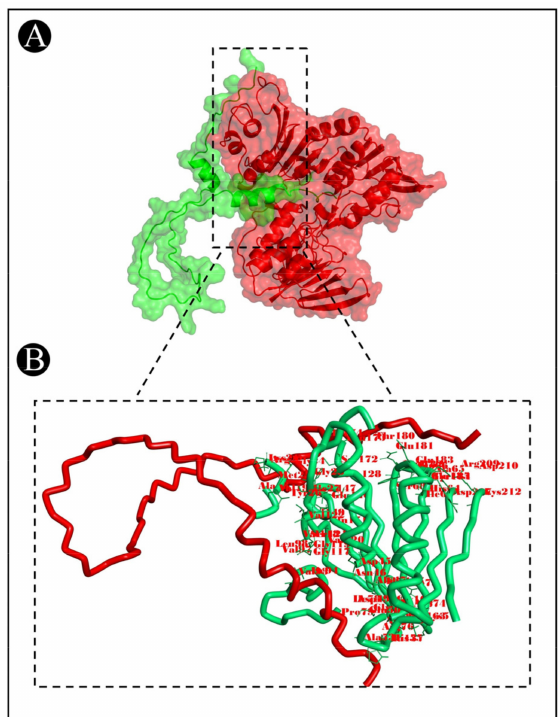
Figure 7. Docking representation of the acidocin A and 2CDU complex. ( A ) The binding interface of the complex, ( B ) the binding interaction between the amino acids.